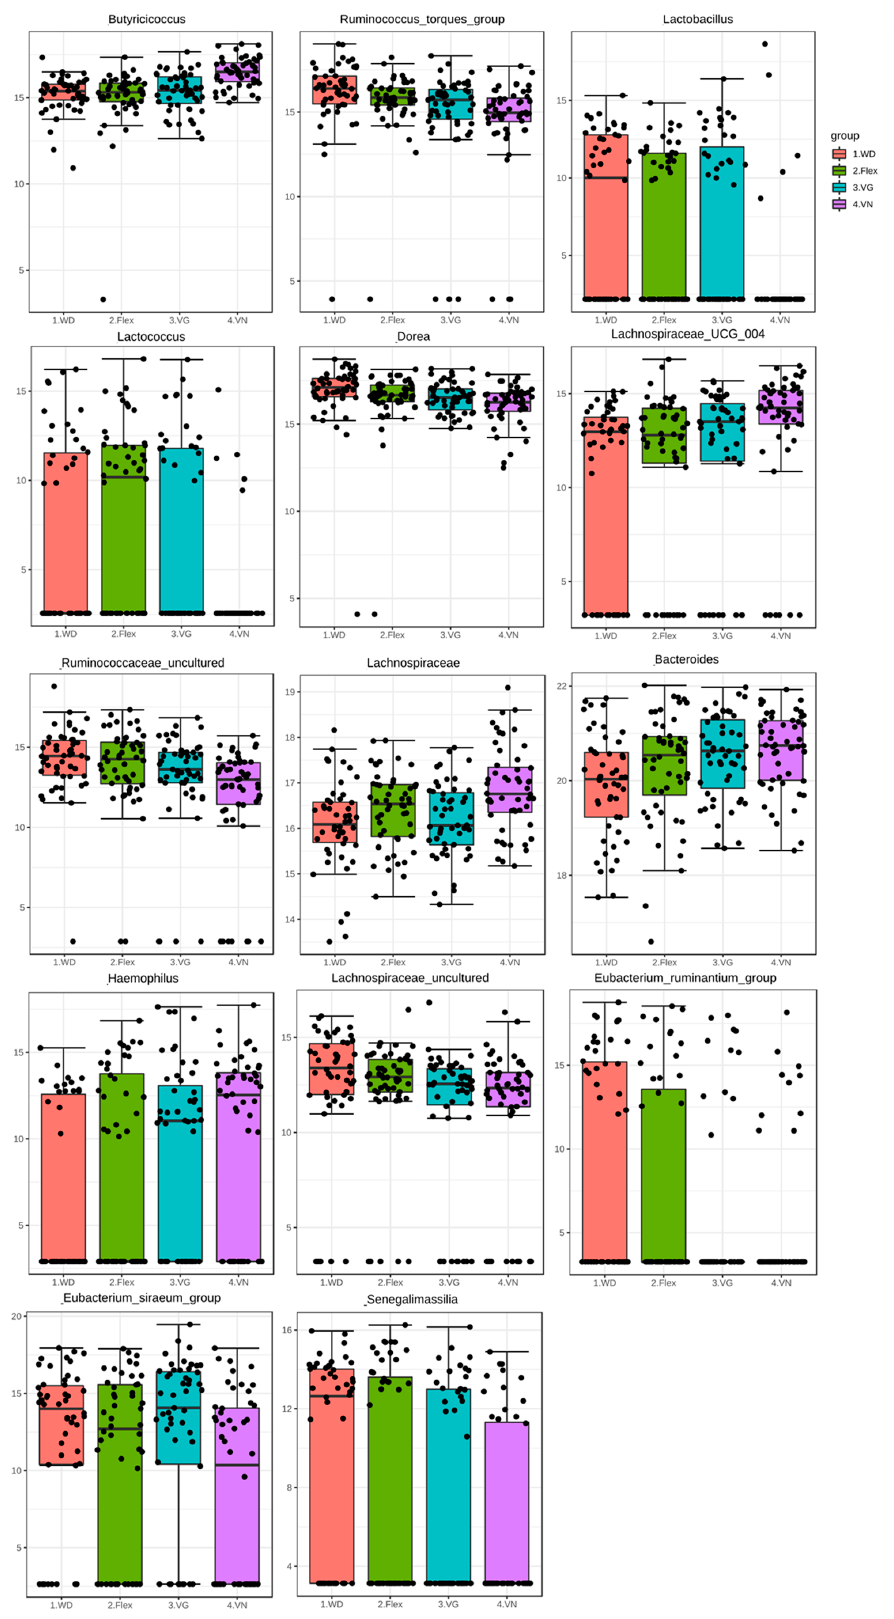
Figure 5. Log-transformed count of the 14 significant biomarkers based on the LefSe analysis. Bar plots with individual sample points are depicted for each diet.